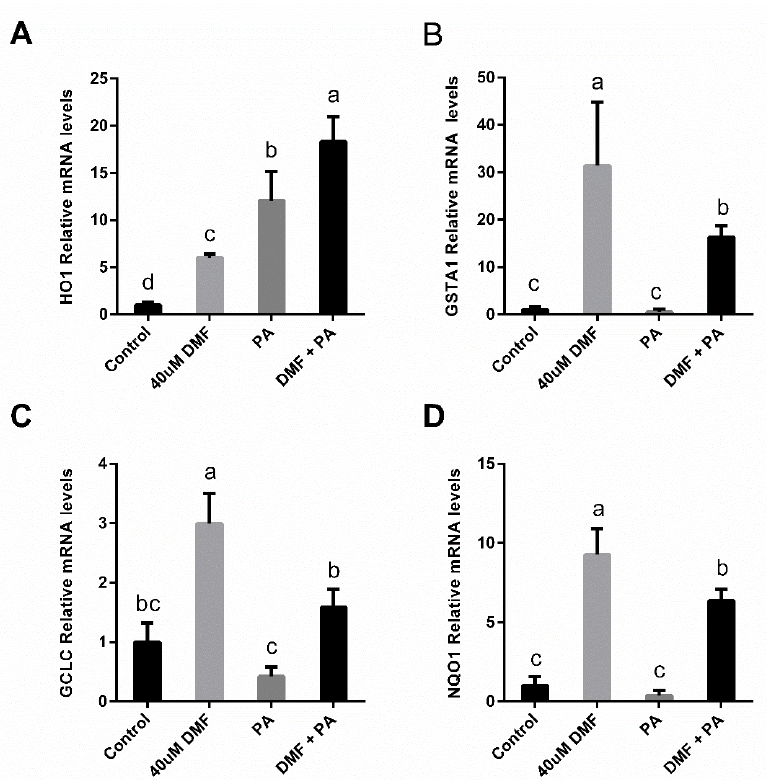
Figure 6. The effect of DMF on Nrf2 activation in PA-induced lipotoxicity. Nrf2-related genes expression ( A – D ) in AML12 hepatocytes treated with 40 μ M DMF for 6 h followed by 0.6 mM PA for another 6 h. Means with different letters are statistically different ( p < 0.05). DMF in combination with erastin and NAC-SNO increased Nrf2-related genes ex- pression compared to untreated control. Both erastin and NAC-SNO increased HO-1 gene expression in cells treated with DMF compared to DMF alone (Figure 7A,B). On the other hand, erastin and NAC-SNO decreased GSTA1 gene expression in cells treated with DMF compared to DMF alone. The combination of erastin and NAC-SNO increased the expression of both genes compared to the control.